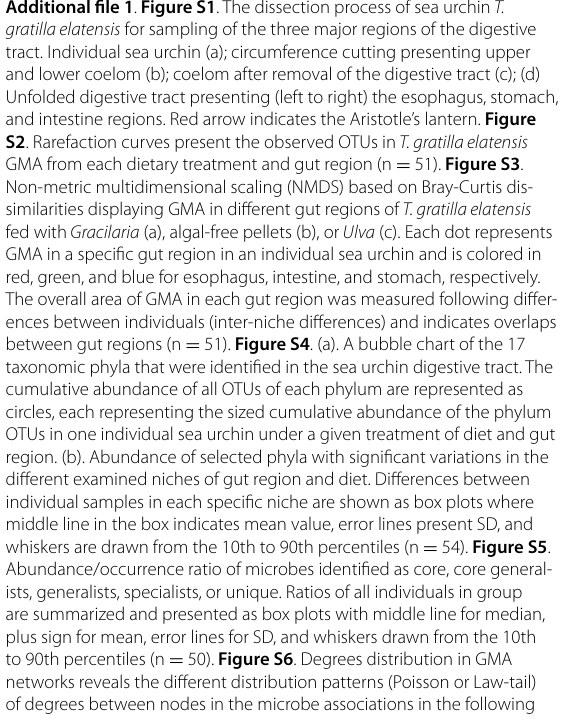
Table S8 . BLAST (Basic Local Alignment Search Tool) results of the closest phylogenetic species that was identified for each of the OTUs that were identified in current research as core, core‑generalist, generalist, specialist, unique, or hub microbes. The bio project number in the NCBI database, where the genome of any of the assigned species is available, is provided. Not